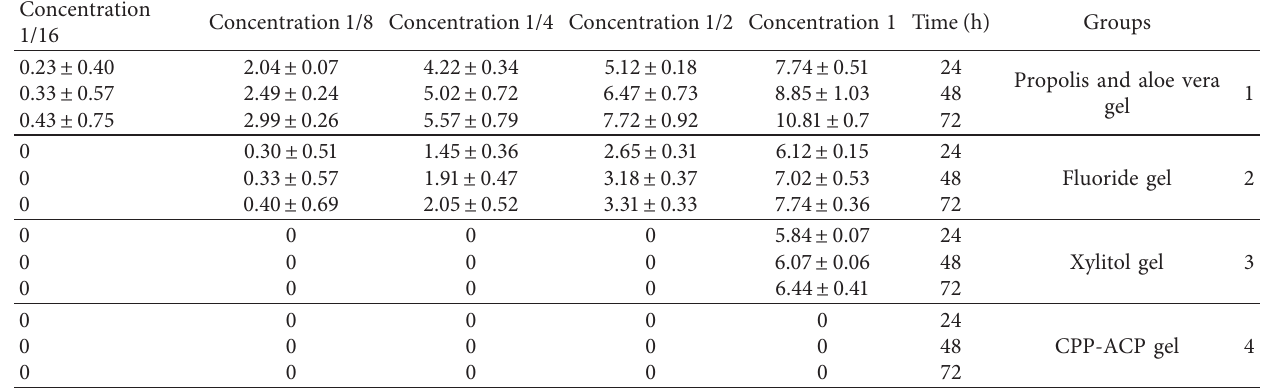
Table 1: Mean diameter ± standard deviation of Streptococcus mutans growth inhibition zone in different concentrations of each gel.